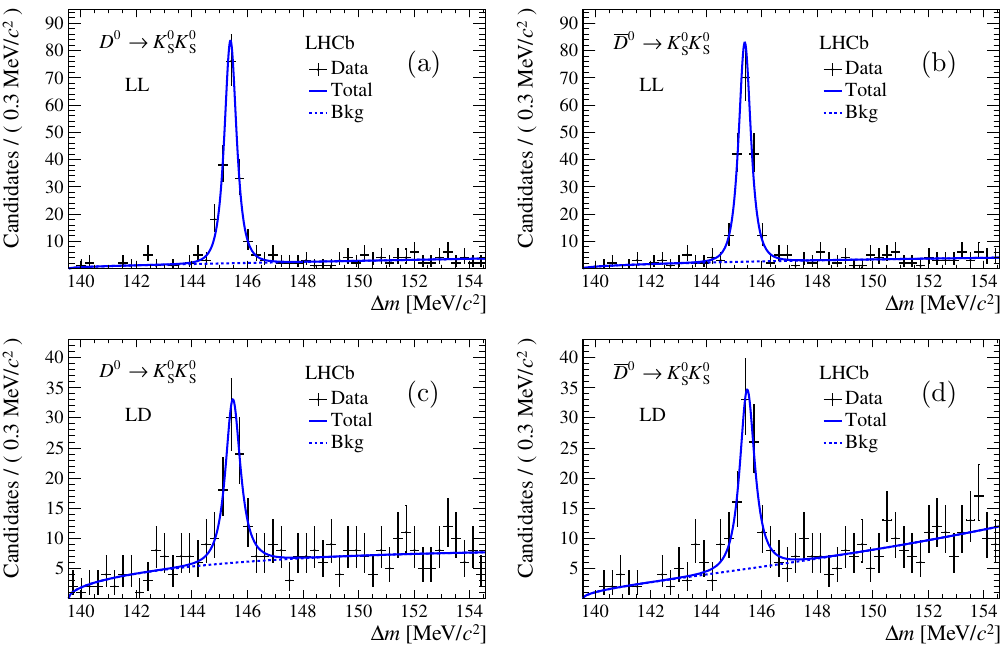
Figure 3 . Results of (cid:12)ts to (cid:1) m distributions of D 0 ! K 0 polarity. The (cid:12)t to (a) D (cid:3) + ! D 0 (cid:25) + and (b) D (cid:3)(cid:0) ! D 0 (cid:25) (cid:0) candidates for the LL sample and the (cid:12)t to (c) D (cid:3) + ! D 0 (cid:25) + and (d) D (cid:3)(cid:0) ! D 0 (cid:25) (cid:0) candidates for the LD sample are shown. The black crosses represent the data points, the solid blue curve is the total (cid:12)t function, and the dashed blue curve is the background component of the